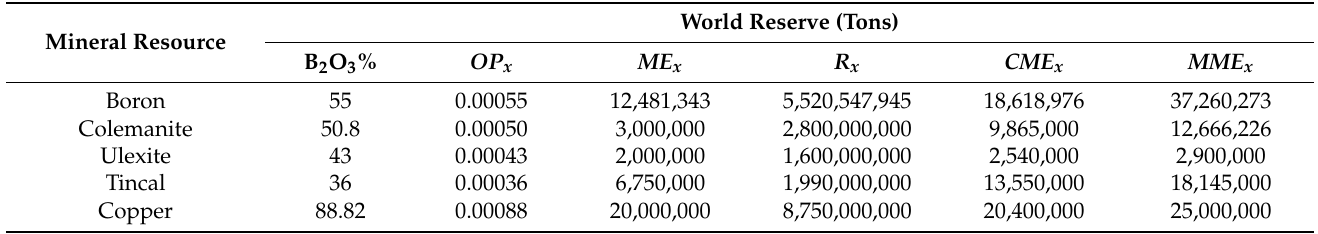
Table 6. Characterization factor that was obtained by ReCiPe method for the world (the year 2020) [32,33].